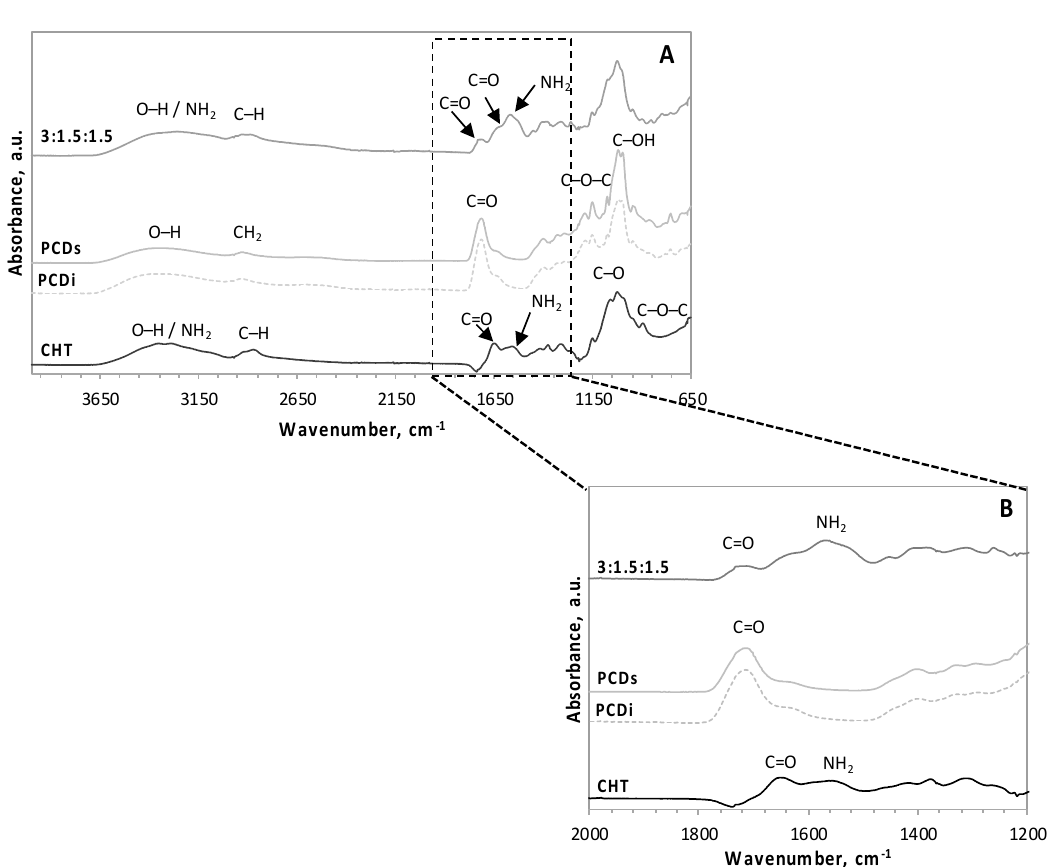
Figure 2. FT–IR spectra of ( A ) the CHT:PCDi:PCDs hydrogel with a 3:1.5:1.5 ratio, the raw CHT, PCDi, and the PCDs spectra, and ( B ) the magnification of the wavenumber region between 2000 and 1200 cm − 1 .